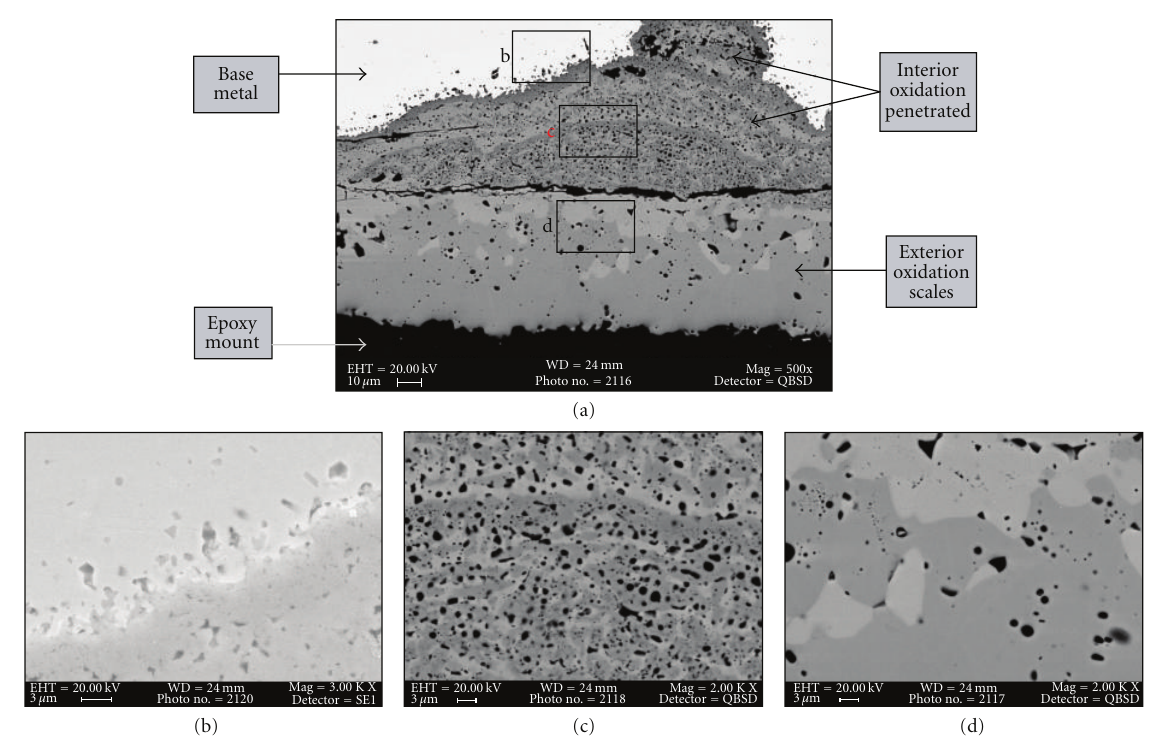
Figure 7: (a) The SEM micrographs of the cross-section of the AISI 304 at 1000 ◦ C for 100 hours at magnification 500x, (b) interface substrate-oxide at 3000x, (c) internal oxidation at 3000x, and (d) external oxidation at 2000x.